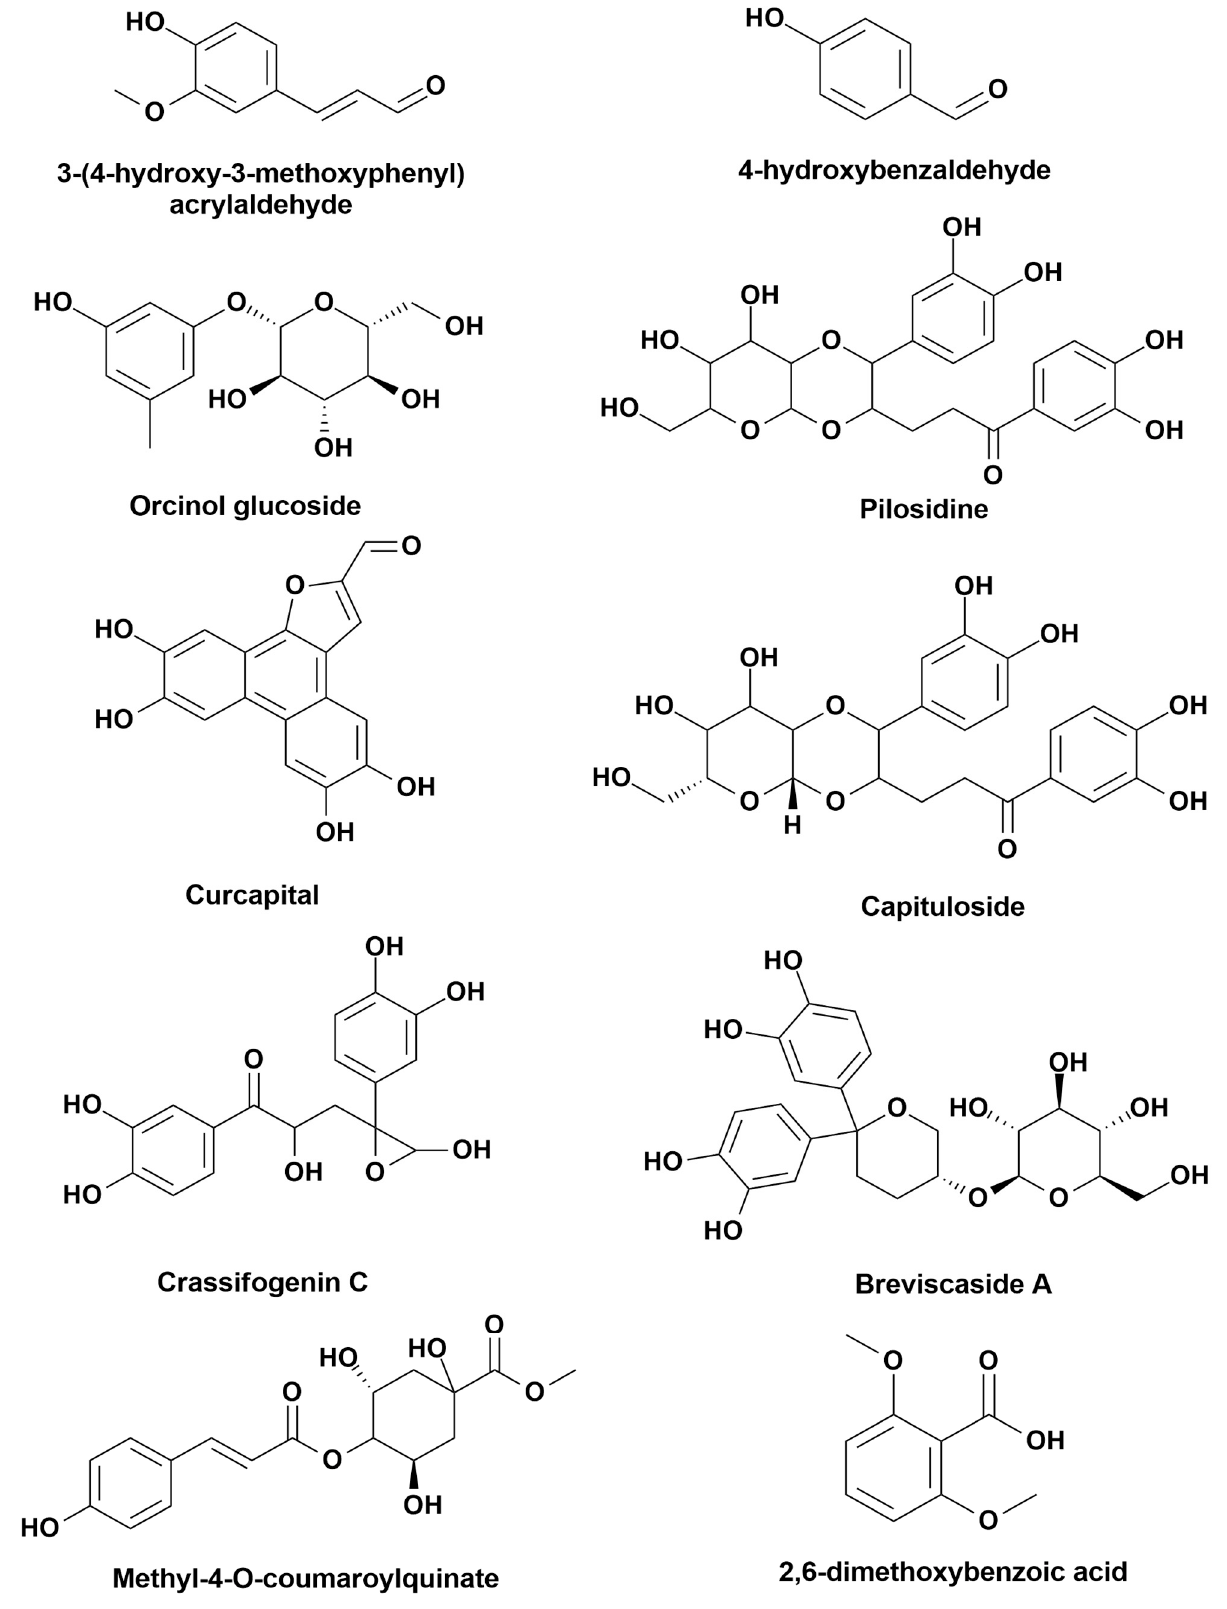
Figure 9. Chemical structures of the compounds used for molecular docking study.